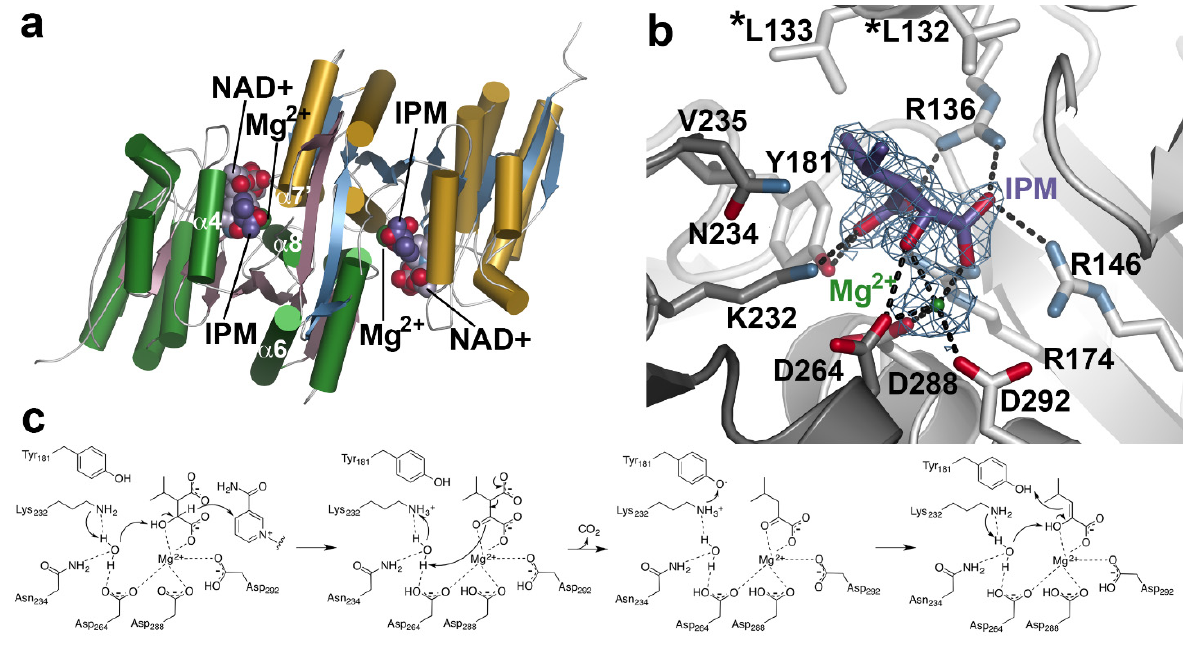
Figure 5. IPMDH Structure and Mechanism. ( a ) Overall structure of AtIPMDH2. The dimeric structure is shown with each monomer colored with green α –helices and rose β –strands or cold α -helices and blue β –strands. Positions of isopropylmalate (IPM), NAD + , and Mg 2+ are shown. ( b ) Active site view. The 2F o –F c omit map (1.5 σ ) for IPM (purple) and Mg 2+ (green) is shown. Dotted lines indicate charge–charge and hydrogen bond interactions. The two leucine residues located near the aliphatic side chain of IPM are indicated by asterisks. ( c ) Proposed reaction mechanism of IPMDH.